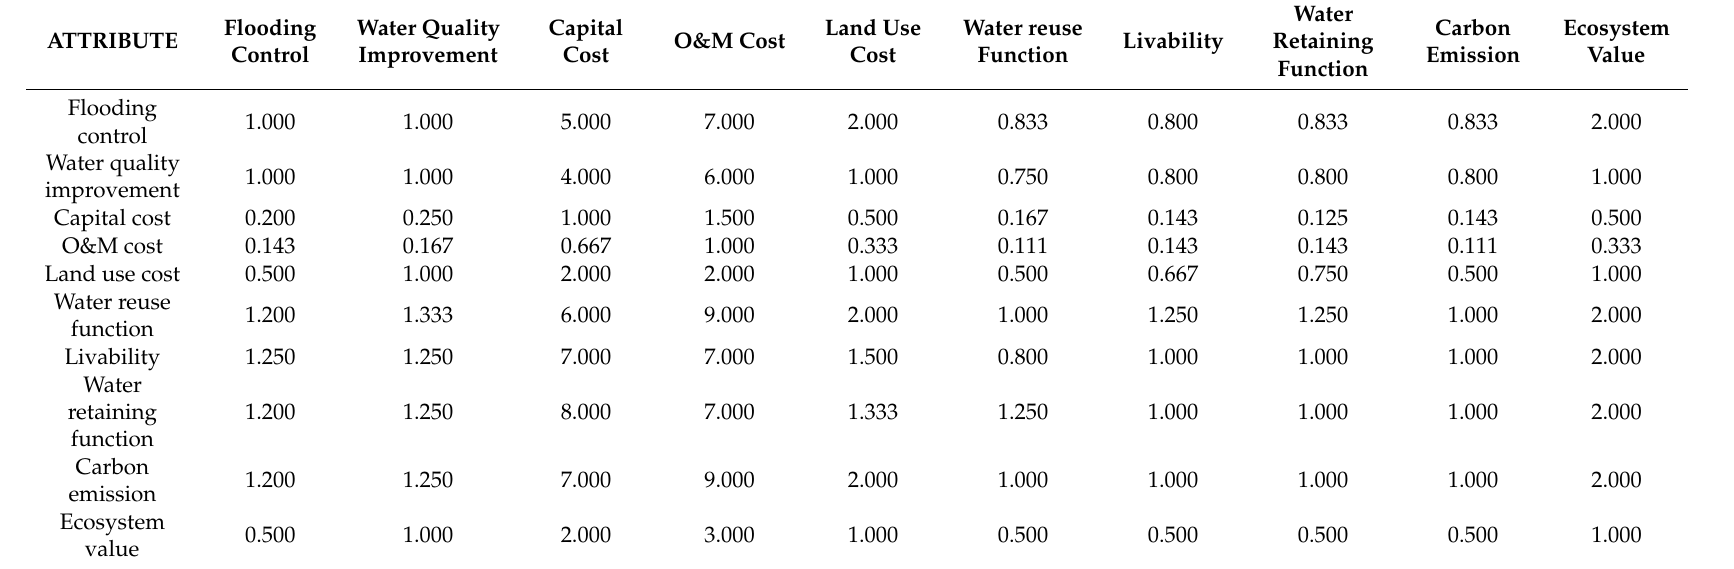
Table A9. Initial pair-wise comparison